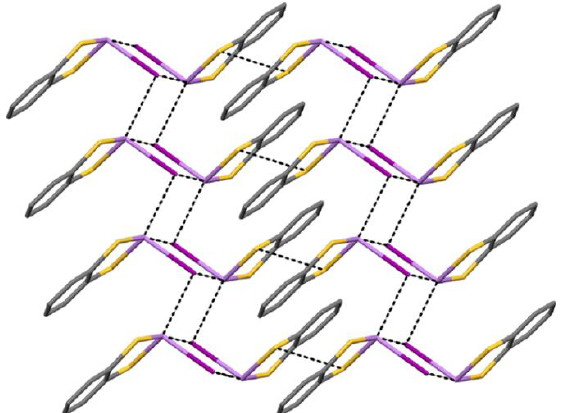
Figure 2. Molecular structure of compounds 1 – 4 .